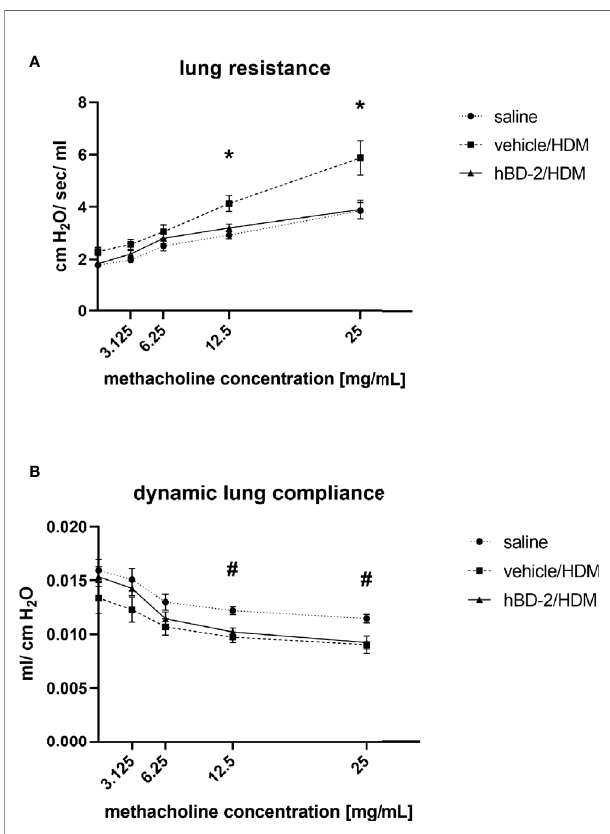
FIGURE 4 | Lung resistance (A) and compliance (B) in 6 mice per group 48 h after saline or HDM challenge. Saline: Mice without treatment and challenged with saline only. Vehicle/HDM: Mice prophylactically treated with vehicle and challenged with HDM. hBD-2/HDM: Mice prophylactically treated with hBD-2 and challenged with HDM. *signi fi cant difference (ANOVA with post-hoc t-test; p<0.05) between vehicle treated and hBD-2 – treated mice; # signi fi cant difference (ANOVA with post-hoc t-test; p<0.05) between saline- challenged and HDM-challenged mice. hBD-2, human beta-defensin 2; HDM, house dust